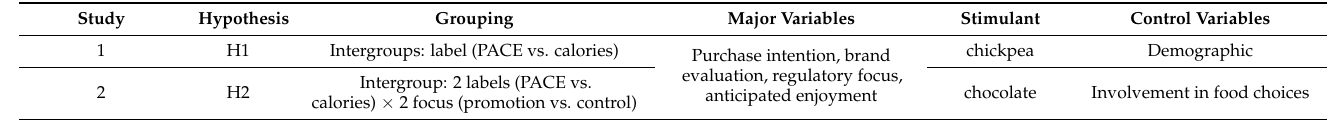
Table 1. General idea of experimental design.